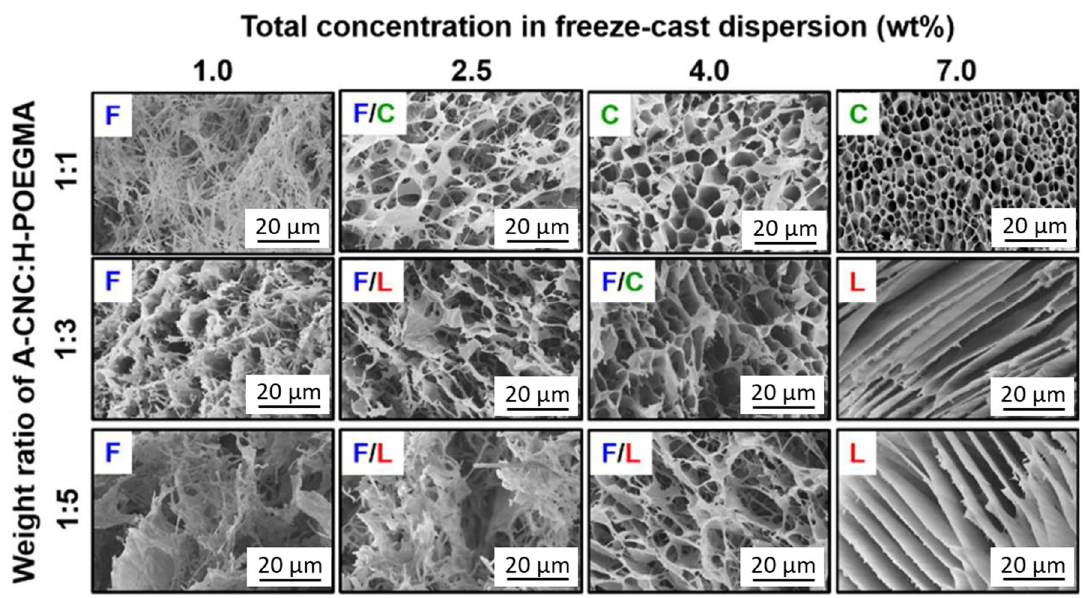
Figure 15. SEM micrographs of CNC foams’ cross‐sections (perpendicular to the ice growth direction) showing the various pore morphologies that can be obtained depending on both the amount of added hydrazide‐functionalised poly(oligoethylene glycol methacrylate) H‐POEGMA and CNC concentration. (Adapted with permission from Chau et al. [148]. Copyright 2016 American Chemical Society).